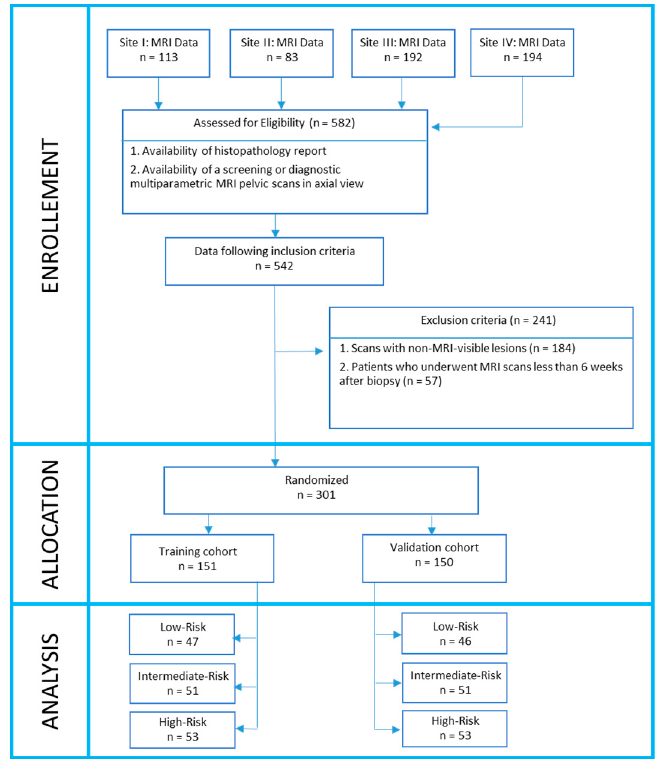
Figure 4. Dataset description. A 231-case dataset leading to 301 prostate cancer lesions was divided into 2 groups. Lesions from Group 1 were used to train machine learning classifiers. Lesions from Group 2 were used for independent validation.